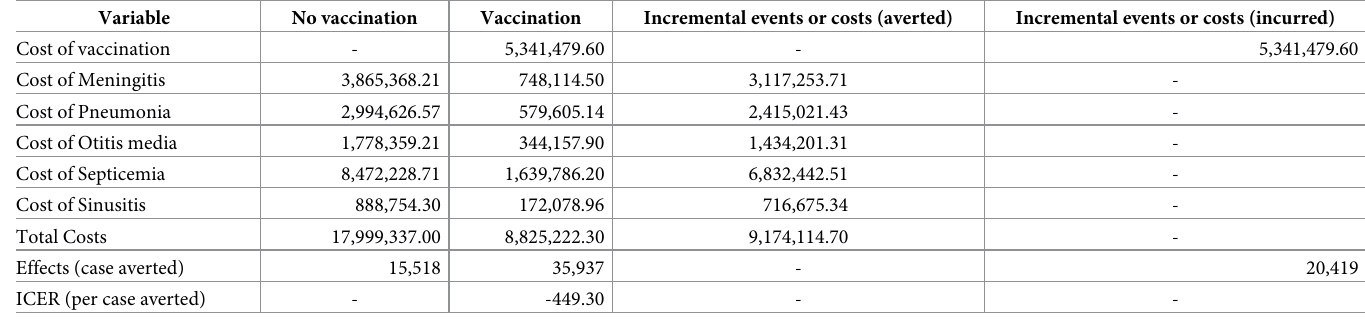
Table 5. Cost-effectiveness analysis of the PPV23 vaccination programme in a cohort of Malaysian Hajj pilgrims.